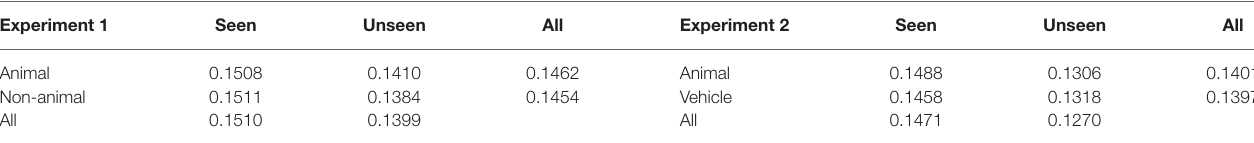
TABLE 1 | Average contrast values based on subjects’